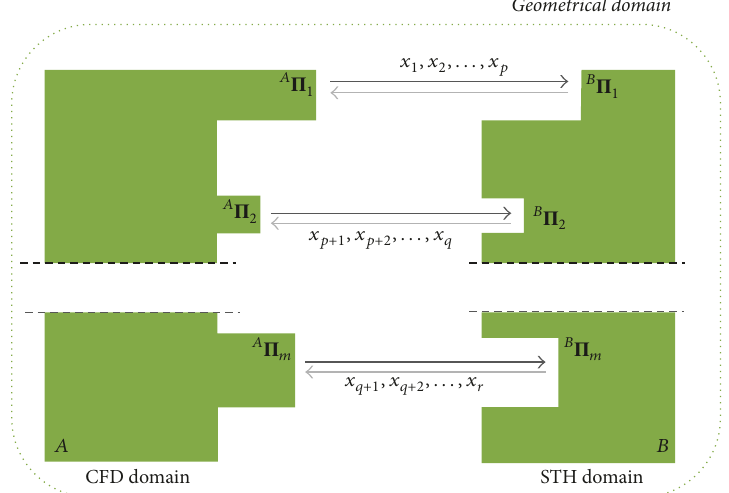
Figure 1: Simplified sketch of a “nonoverlapping,” “two-ways” coupled